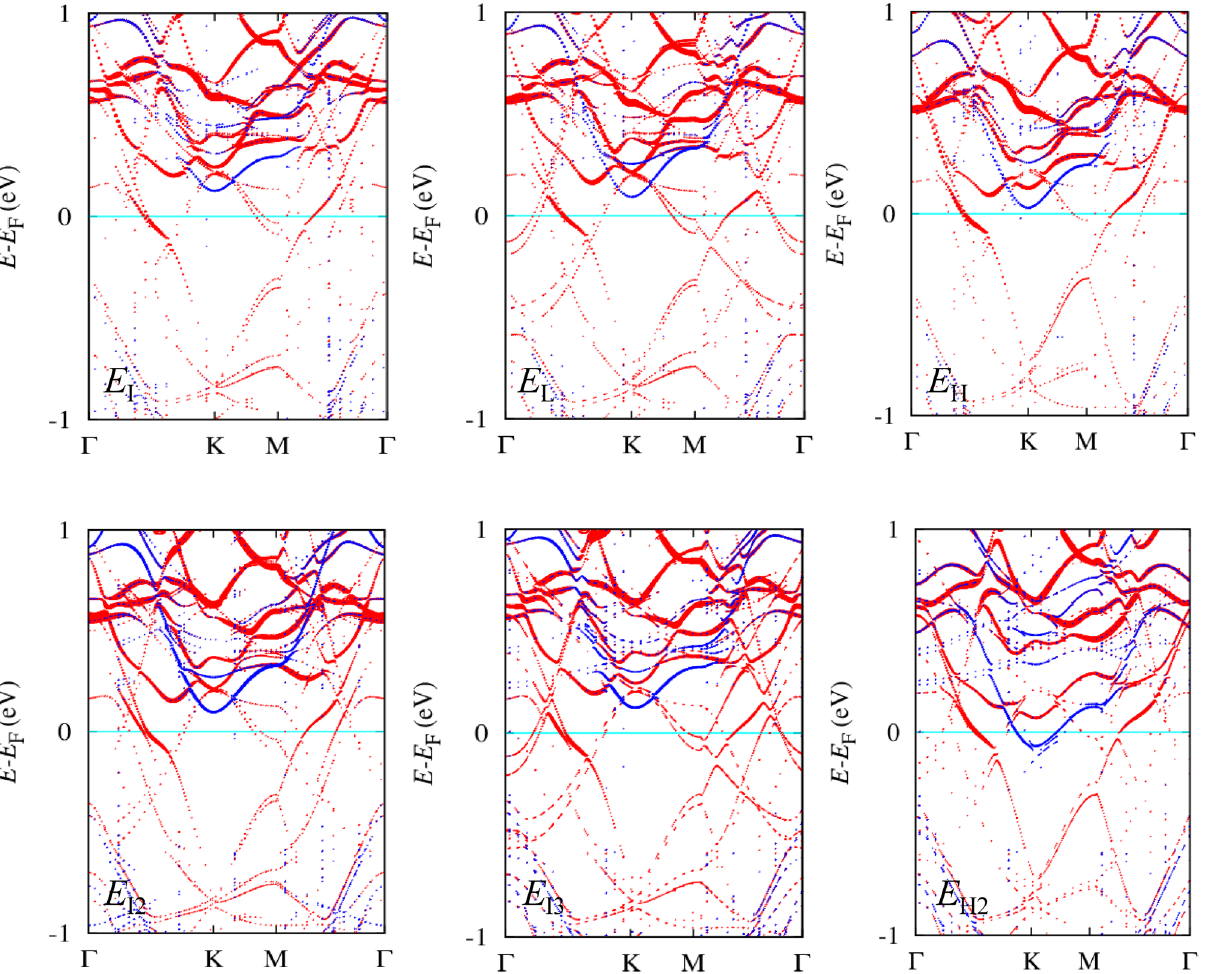
Figure 4. Band structures projected on a Cr atom for various stacked structures. The band structures are obtained by the noncollinear PBE + U + SOC method ( U = 3.5 eV and J = 1.0 eV applied to Cr 3 d orbitals). The red (blue) color is for spin-up (spin-down) bands; the color intensity corresponds to the projection